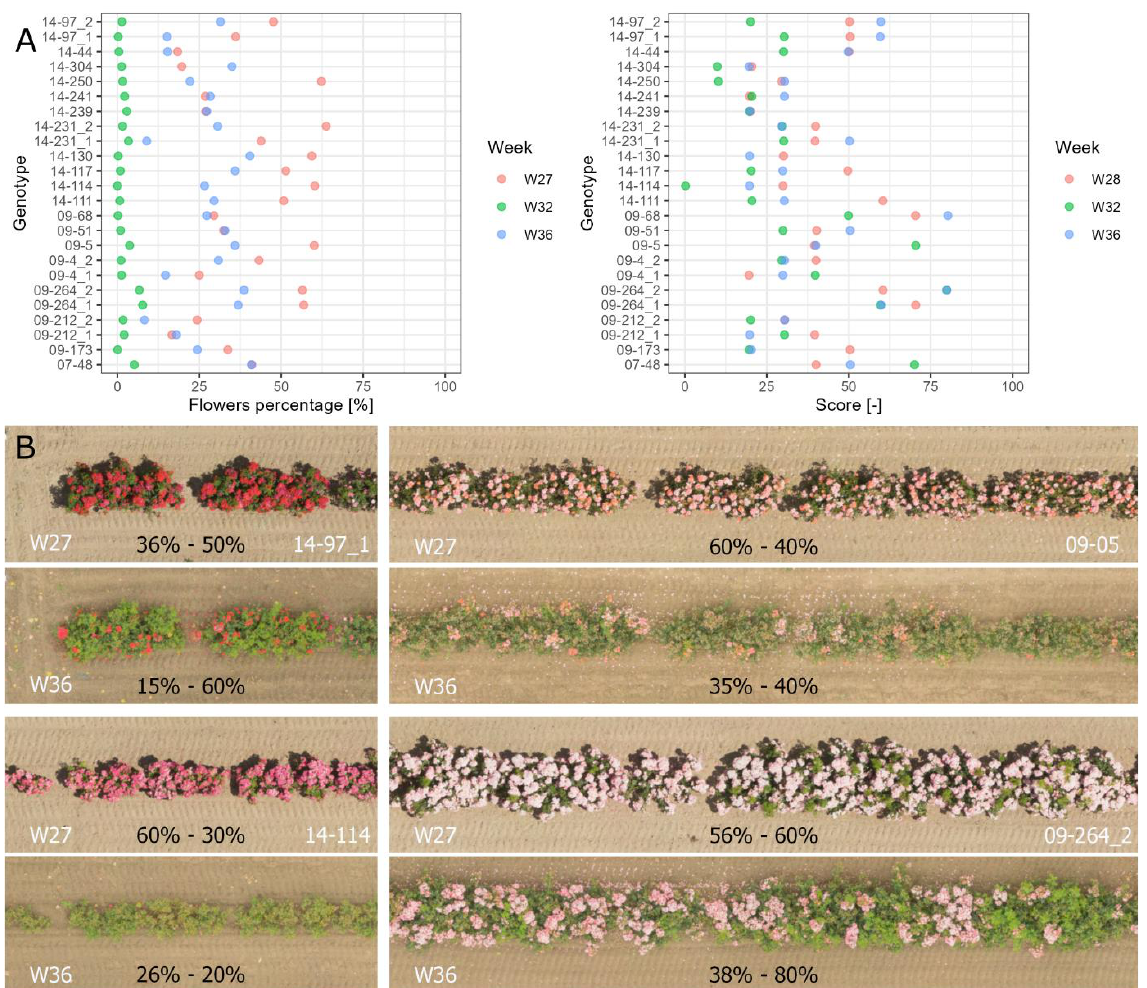
Figure 5. ( A ) Evolution of flower percentage and scores per week for a set of genotypes and ( B ) imagery of four genotypes in the first and last week with percentages derived from the UAV imagery and scores.